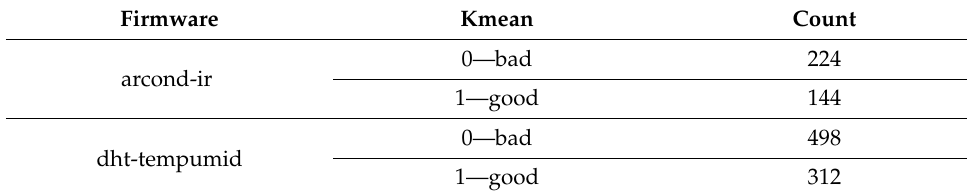
Table 3. Remote lab ESP32 clustering